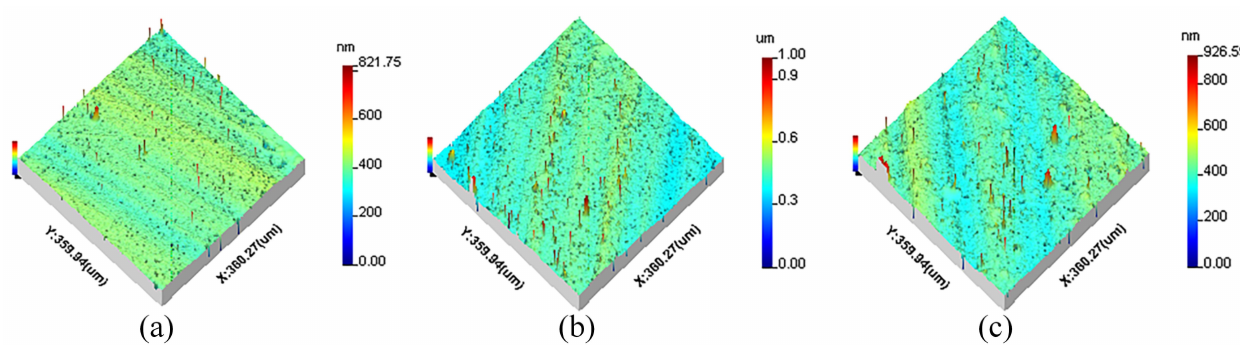
Figure 2. The original 3D surface topography of different feed rates: ( a ) f = 8 µ m/r, ( b ) f = 12 µ m/r, ( c ) f = 18 µ m/r.